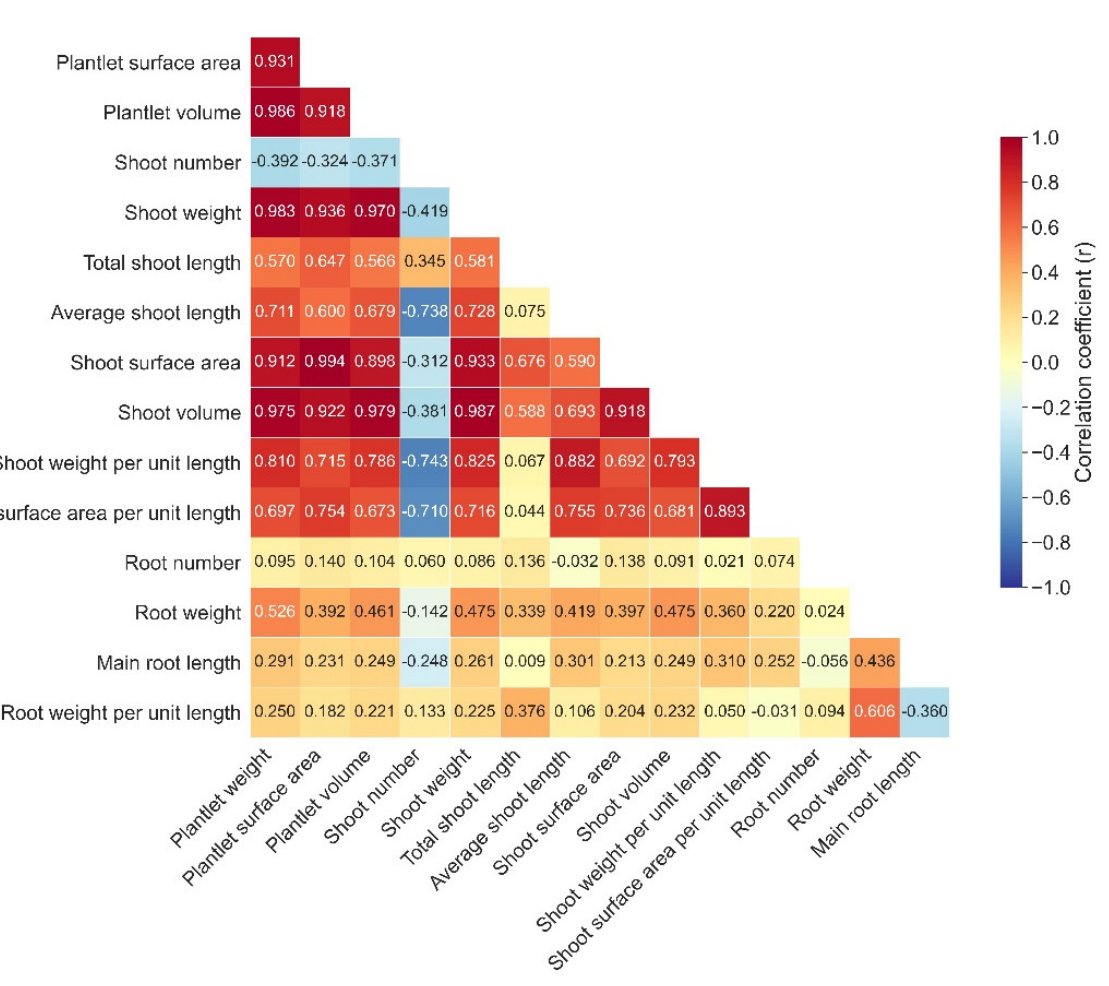
Figure 7. Heat map of Pearson’s correlation coefficients for in vitro plantlet growth characteristics of Hylocereus polyrhizus ‘Da Hong’ incubated in a culture room at 25 °C ± 2 °C with a 16/8 h (L/D) photoperiod under 50 µmol/m 2 /s fluorescent light.